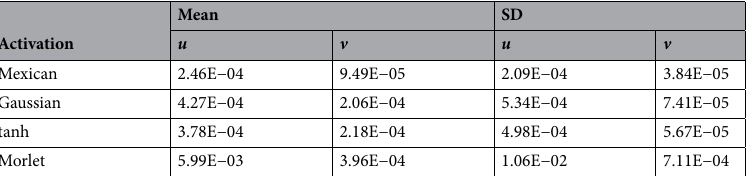
Table 3. Average and SD of relative L 2 error of the proposed method in solving non-linear coupled equation using different activation function compared against the analytical solution over 10 instances.